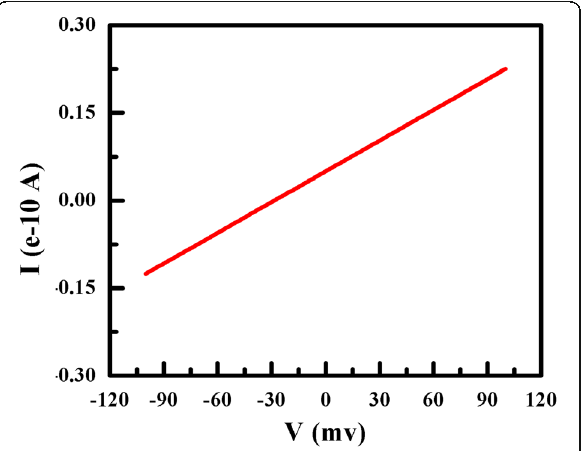
Fig. 10 The electrical transport measurement of α -SiNW in Fig.